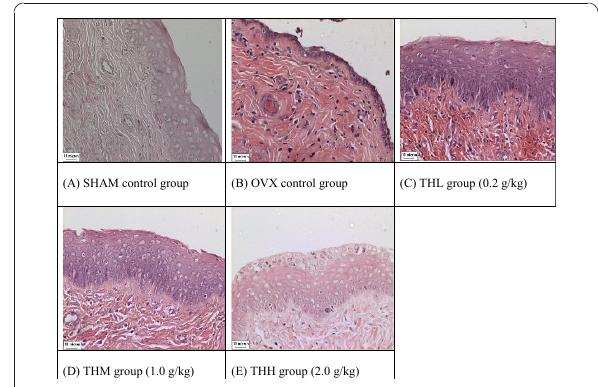
Figure 2 Effects of Tualang honey on vagina morphology in rats . OVX control group showed an atrophic vaginal epithelium with composed of a few layers of flattened cells. After 2 weeks administration of Tualang honey at all doses caused a complete reversal of the vaginal atrophy. This effect was accompanied by hyperplasia and hypertrophic of vaginal epithelium. The cytoplasmic vacuolization was clearly present in THH group. All pictures are stained with H&E and examined under ×20 magnification: SHAM = Sham-operated control rats, OVX = ovariectomised non-honey treated control rats, THL = Tualang Honey, low dose, THM = Tualang Honey, medium dose, THH = Tualang Honey, high dose.